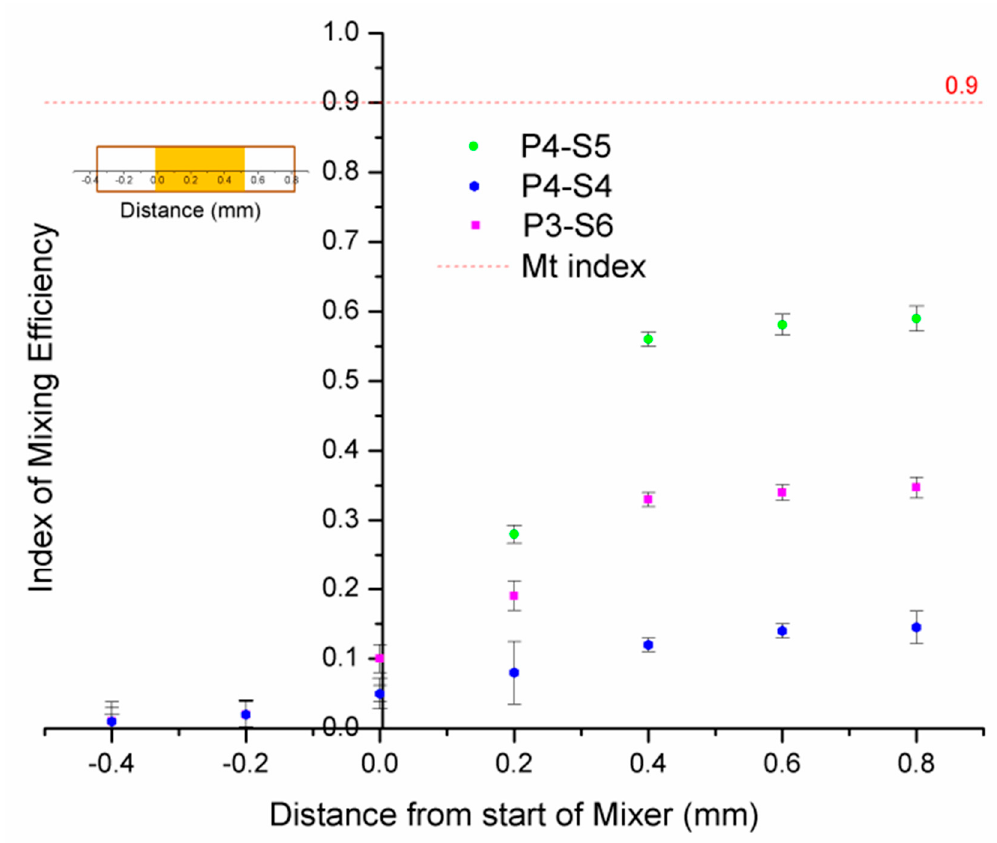
Figure 13. The index of the mixing efficiency before, in, and after the mixing channel. Length of mixing channel = 500 µm, applied potential = 300 V/cm.